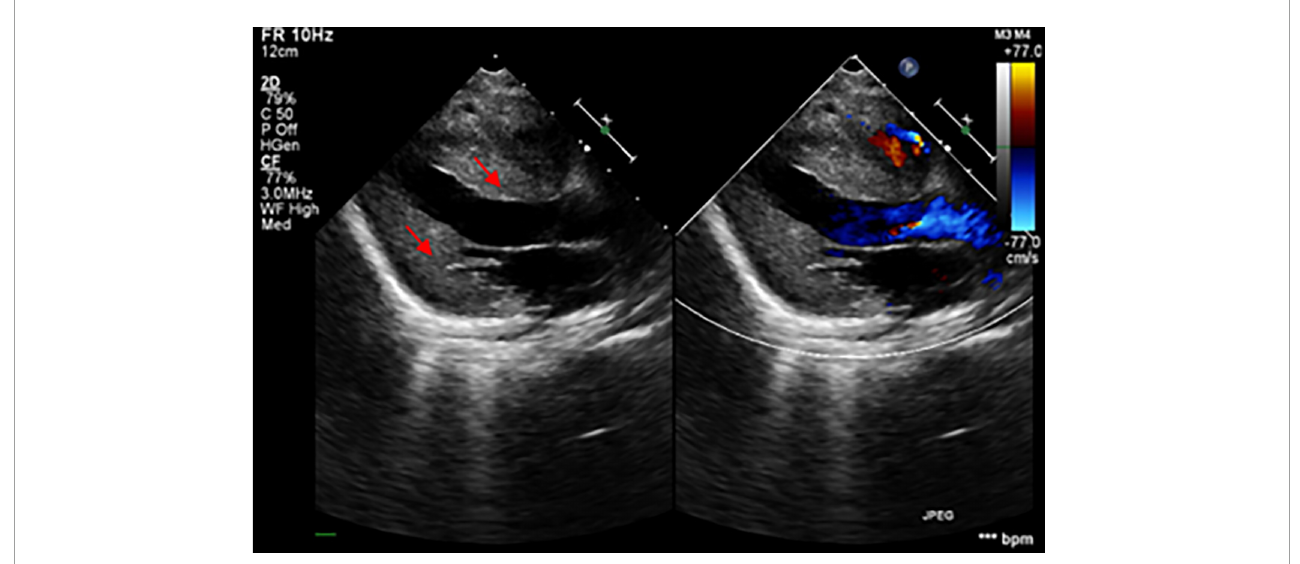
FIGURE1 The echocardiogram demonstrated the thickening of the myocardium (the red arrows showed the hypertrophic interventricular septum and posterior wall of the left